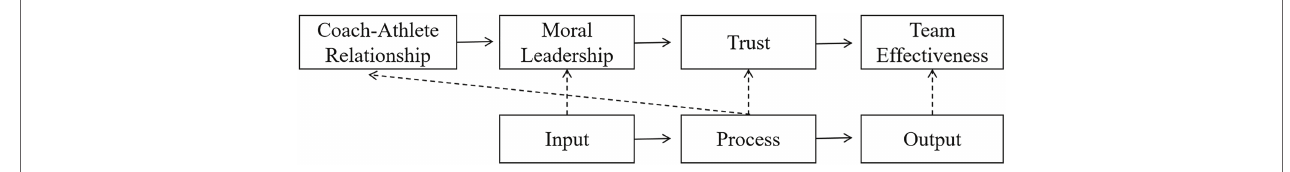
FIGURE 3 | The theoretical framework model of this